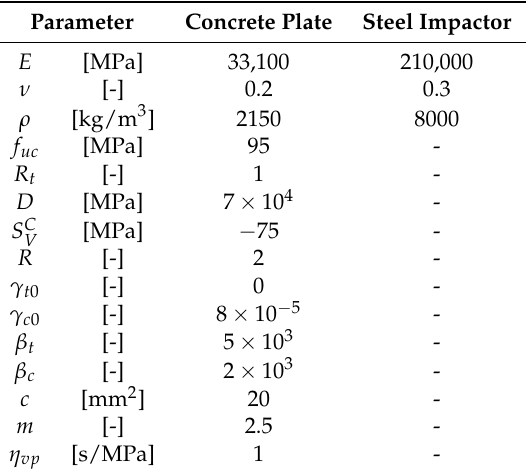
Figure 21. Finite element mesh of thin plate impact test: ( a ) geometry and ( b ) dimensions of the steel impactor. Table 3. Material properties for the thin plate impact